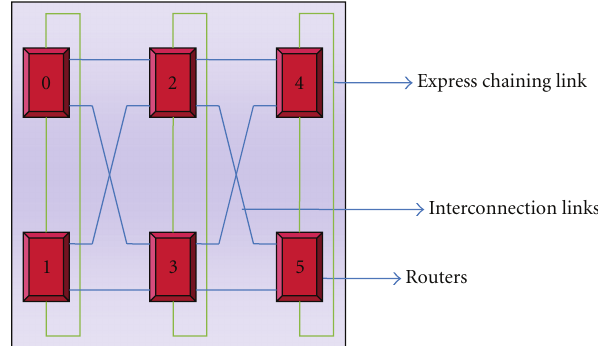
Figure 4: HXN as Interconnect-on-chip.